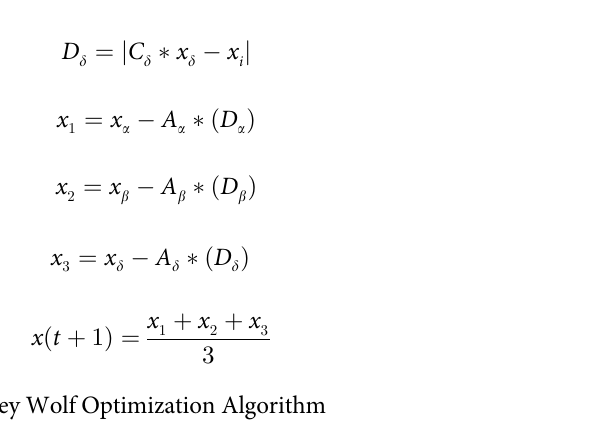
Algorithm 1 : The basic Grey Wolf Optimization